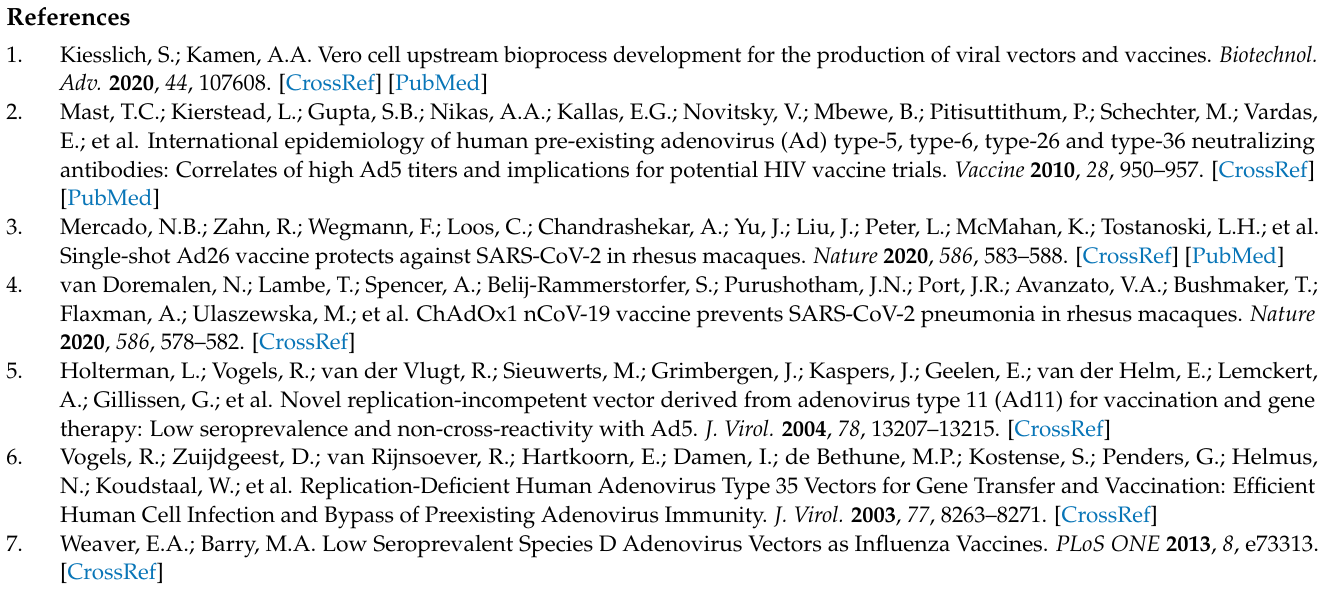
Figure S2: Time course curve of capacitance for the perfusion bioreactor.; Figure S3: UV 280 nm, UV 260 nm, and the concentration of buffer B curves for the continuous flow